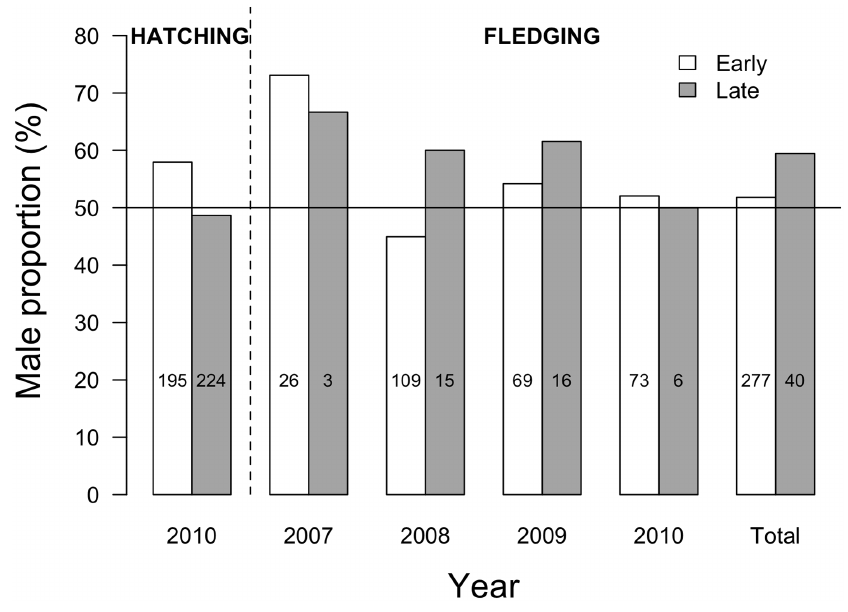
Figure 2. Sex ratio of king penguin chicks produced either early or late during the 2007–2010 breeding seasons. Sex ratio is presented as male proportion (%). White and grey bars correspond to early and late chicks, respectively. In 2010, chick sex was determined both at hatching and fledging. Sample sizes are specified in the